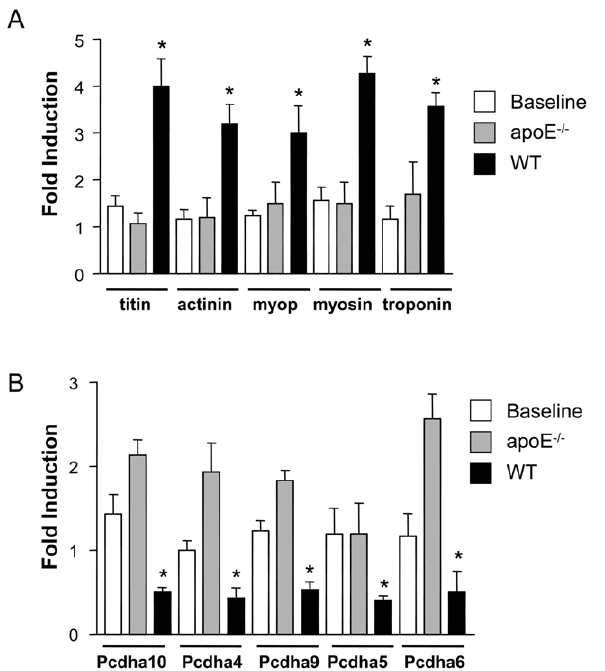
Figure 4. Regression is characterized by macrophages express- ing M2 markers. (A) qPCR analysis for RNA encoding arginase I (Arg I), CD163 and C-lectin receptor was performed on RNA extracted from CD68 + cells removed from plaques that were not transplanted (baseline), plaques transplanted into apoE 2 / 2 recipients (progression environment) and plaques transplanted into wild type recipients (WT, regression environment). The symbol * corresponds to statistical significance, p , 0.05, when signal in RNA from transplanted aortas (apoE 2 / 2 , WT) was compared to signal in RNA from aortas in donor apoE 2 / 2 mice (Baseline). 9 mice were analyzed per group. Cyclophilin A was used for normalization. (B), qPCR analysis for RNA encoding Cxcl2, Cxcl5 and IL1b. The symbol * corresponds to statistical significance, p , 0.05, when signal in RNA from apoE 2 / 2 was compared to signal in RNA from WT mice. 9 mice were analyzed per group. GAPDH was used for normalization. (C) Arginase I staining shows increased protein levels in